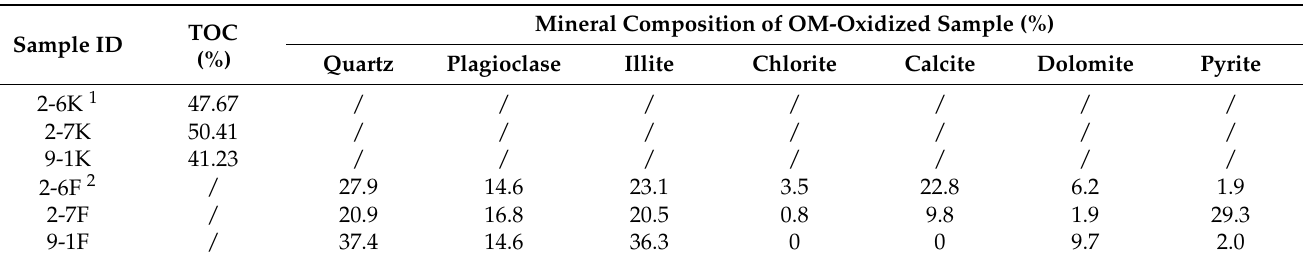
Table 4. TOC and mineral composition of isolated kerogen and OM-oxidized